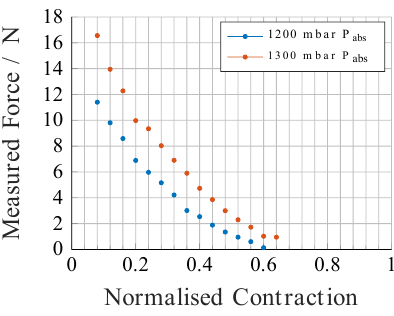
Figure 9. Measured force exertion of an actuator blocked at given contraction